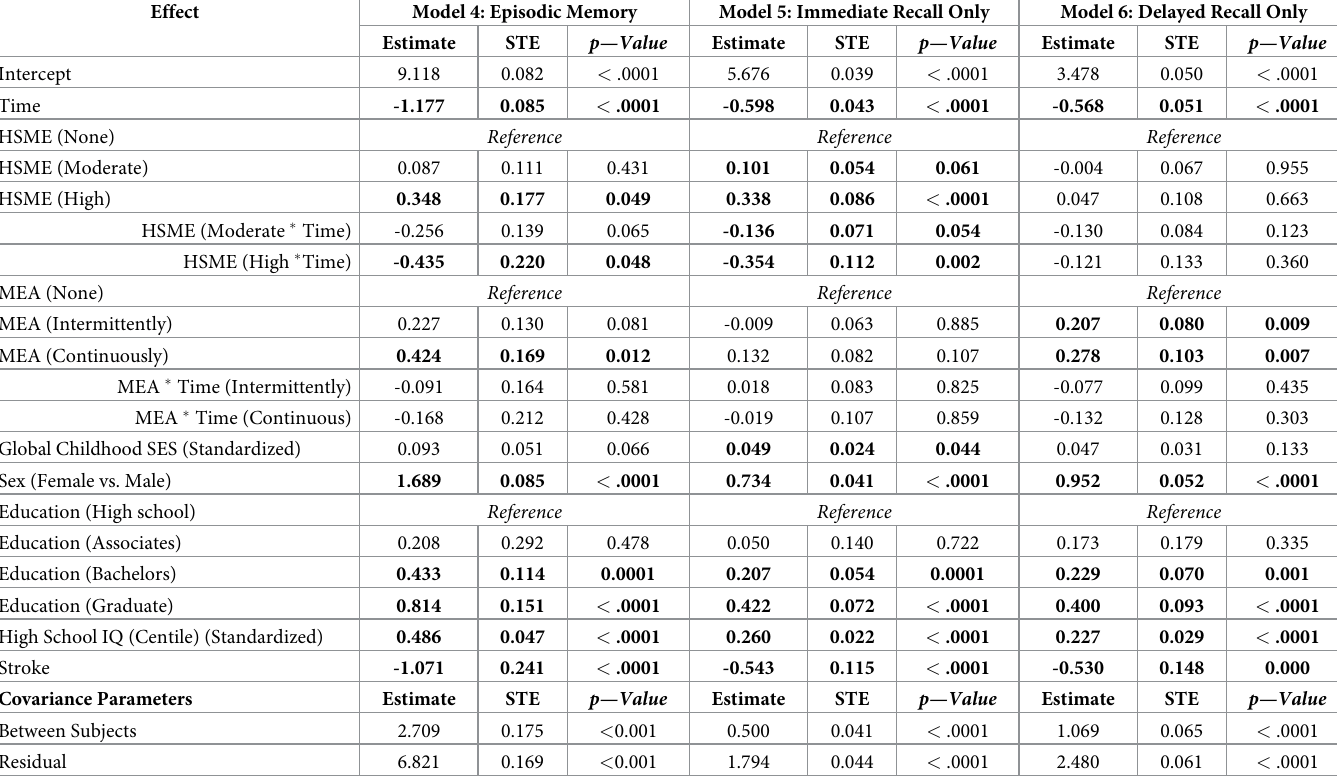
Table 3. Adjusted models to predict episodic memory, immediate recall and delayed recall